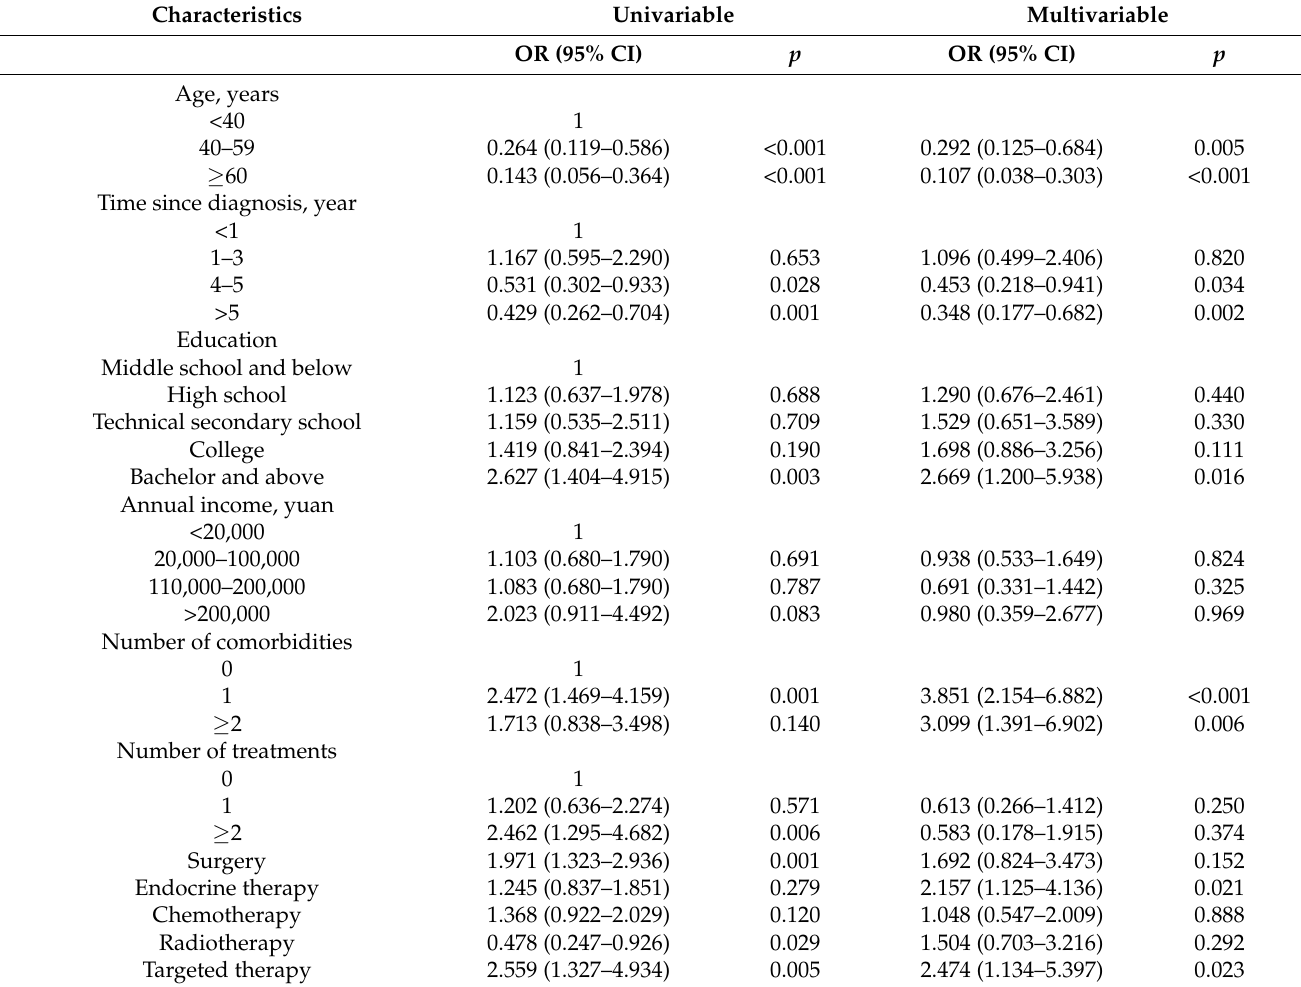
Table 2. Univariable and Multivariable logistic regression for adverse events.